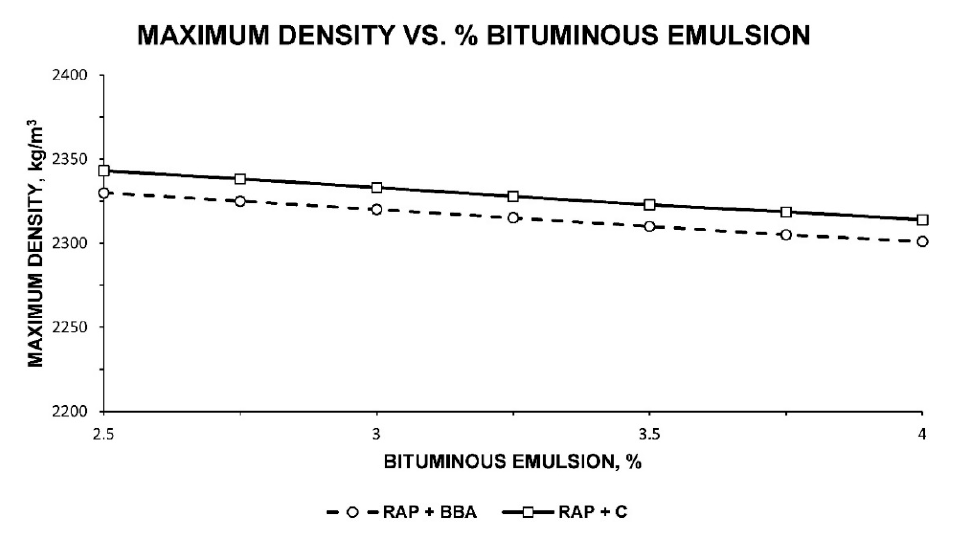
Figure 7. Graph of the results of the maximum density test, standard UNE-EN 12697-5, for bitumi- nous mixes made with RAP and BBA (RAP + BBA), as well as for bituminous mixes with RAP and limestone aggregate (RAP + C).